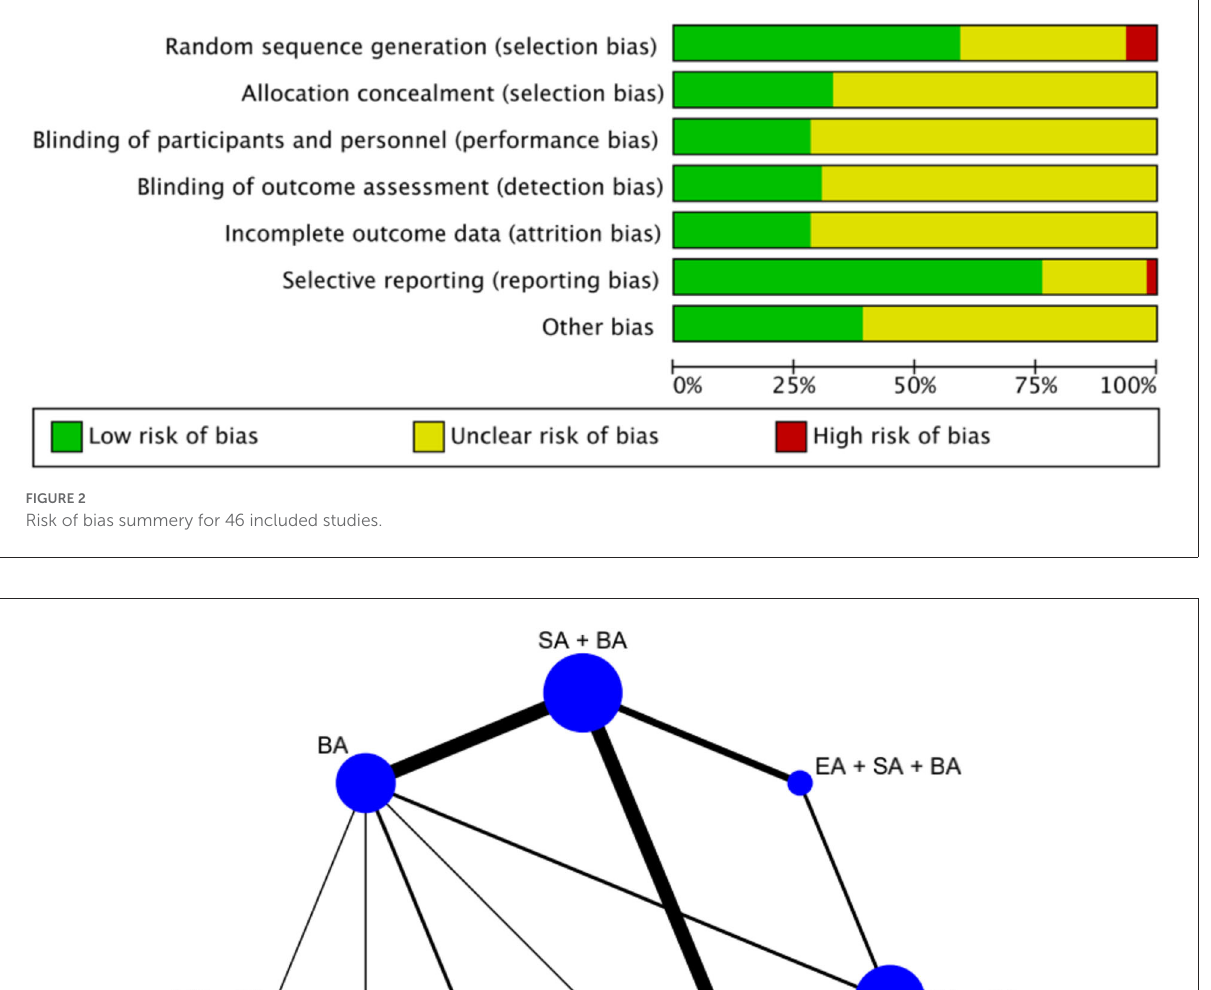
FIGURE3 Network plot of cognitive function.